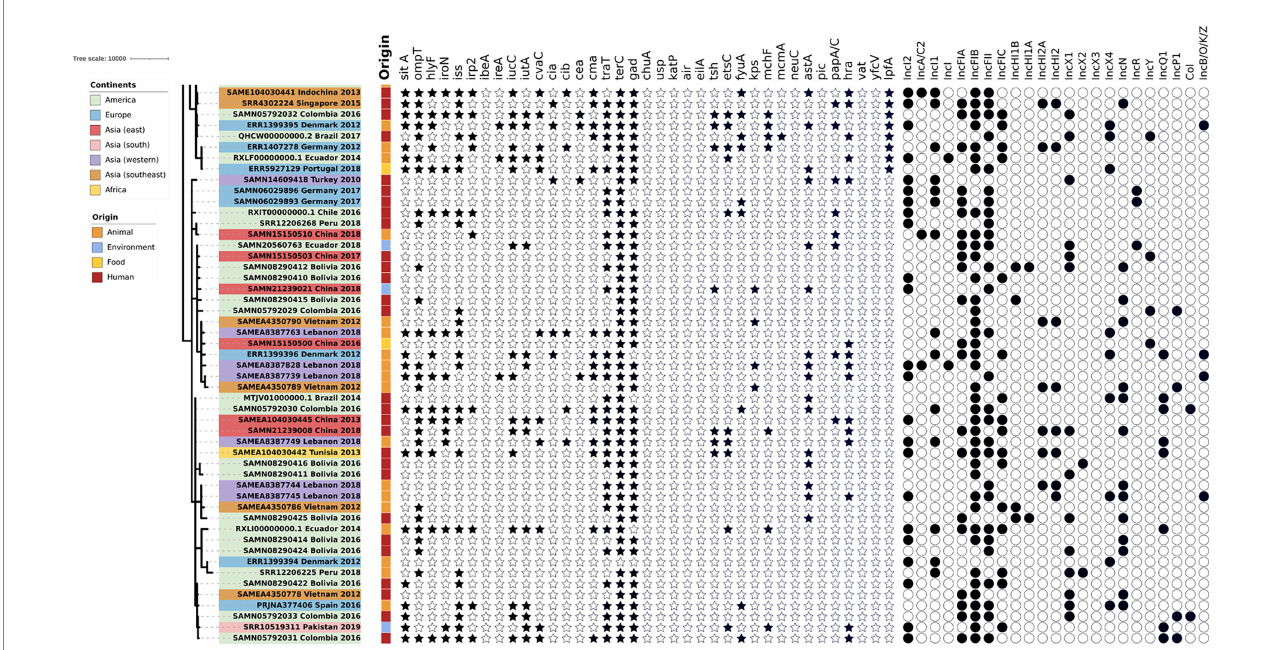
FIGURE 3 Virulence genes and plasmid content of the evaluated E. coli sequences (Part two). The source of the isolates is specified by different colors in the genomic cg-MLST tree branches. The presence and absence of virulence genes and plasmid incompatibility groups are indicated by star and circle symbols, respectively.